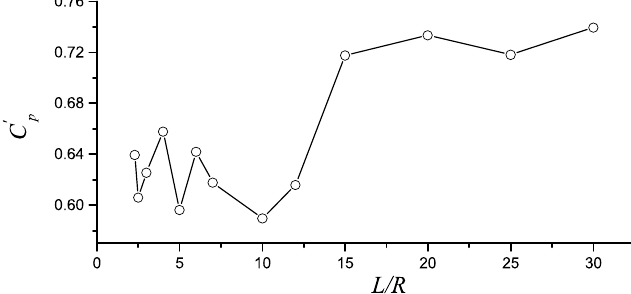
Figure 5. The changes of power coefficient with spacing where the tip speed ratio λ = 2.